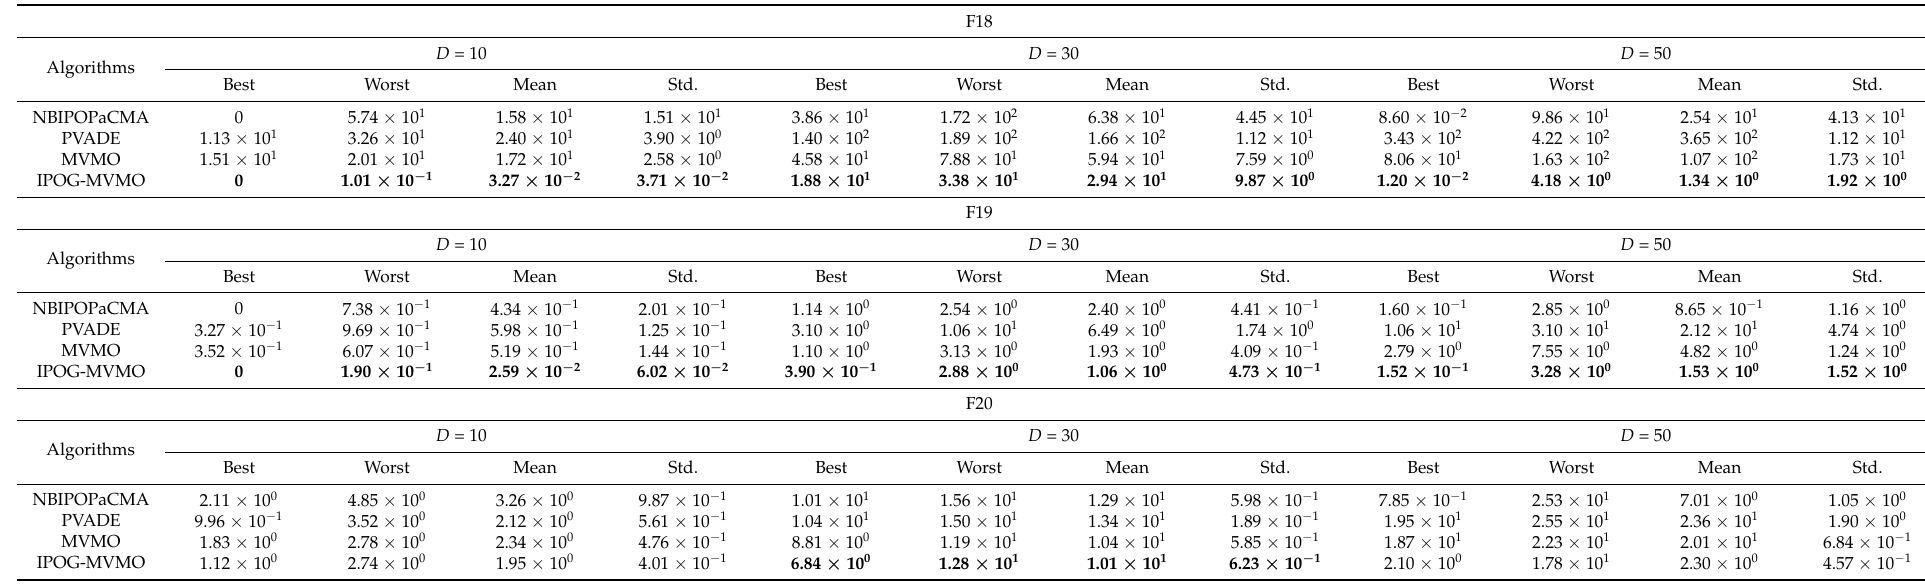
Table 6. The comparative results of the errors obtained from composition functions